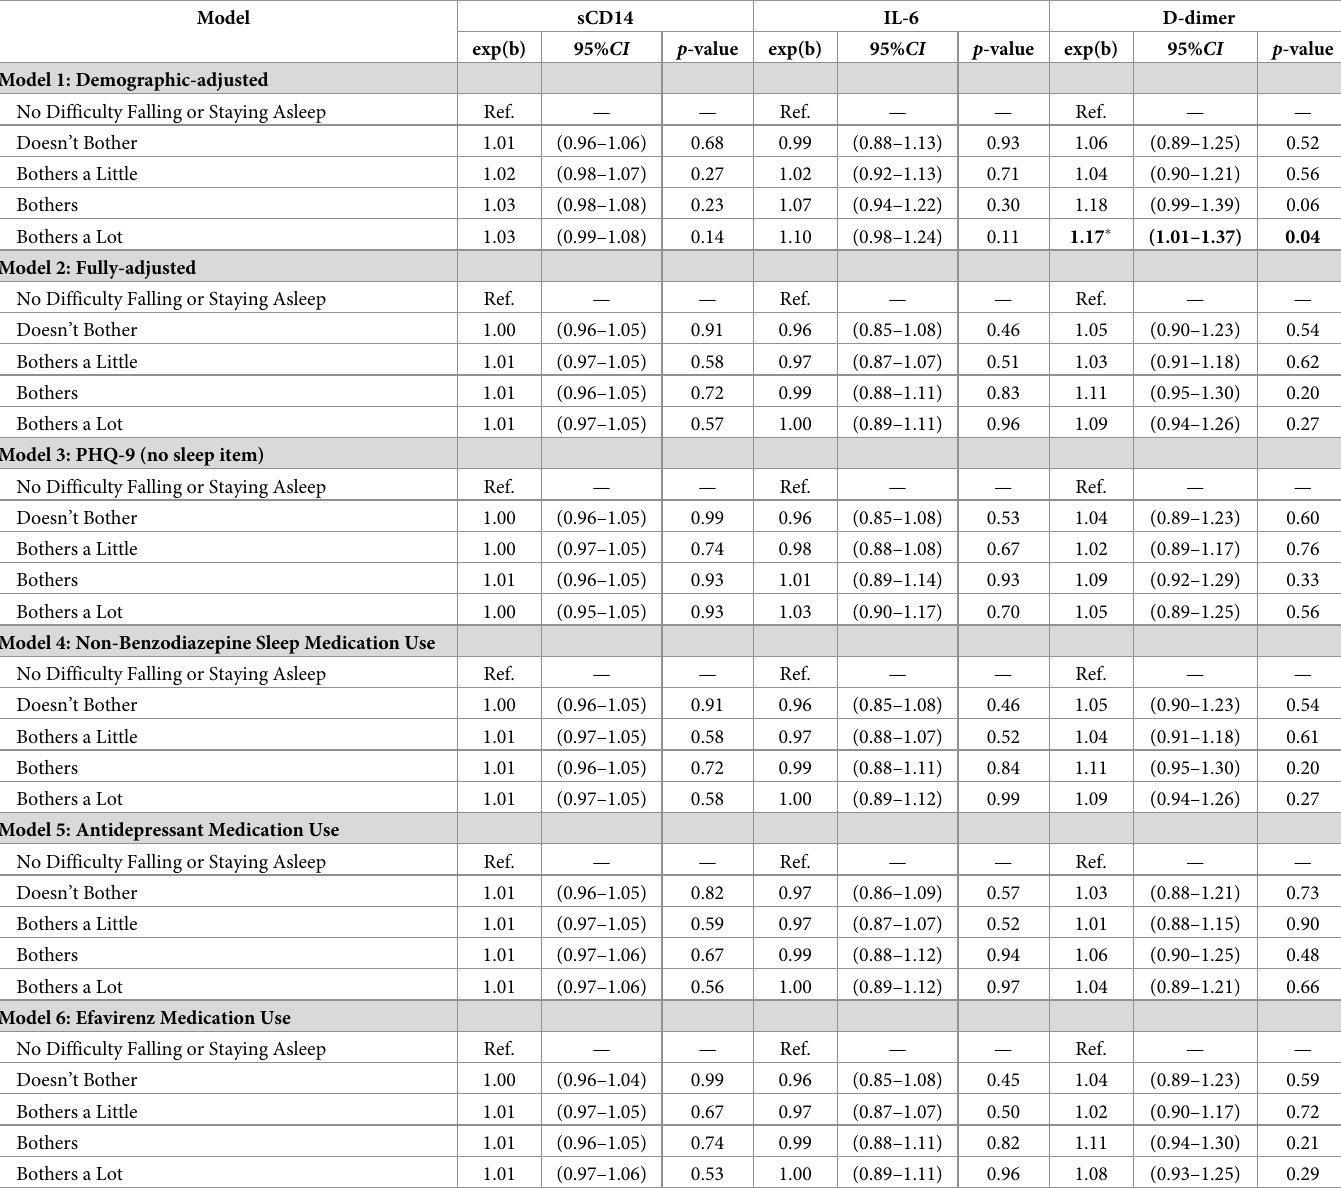
Table 3. Associations of insomnia symptoms categories with sCD14, IL-6, and D-dimer levels in veterans with HIV in the VACS biomarker cohort ( N =